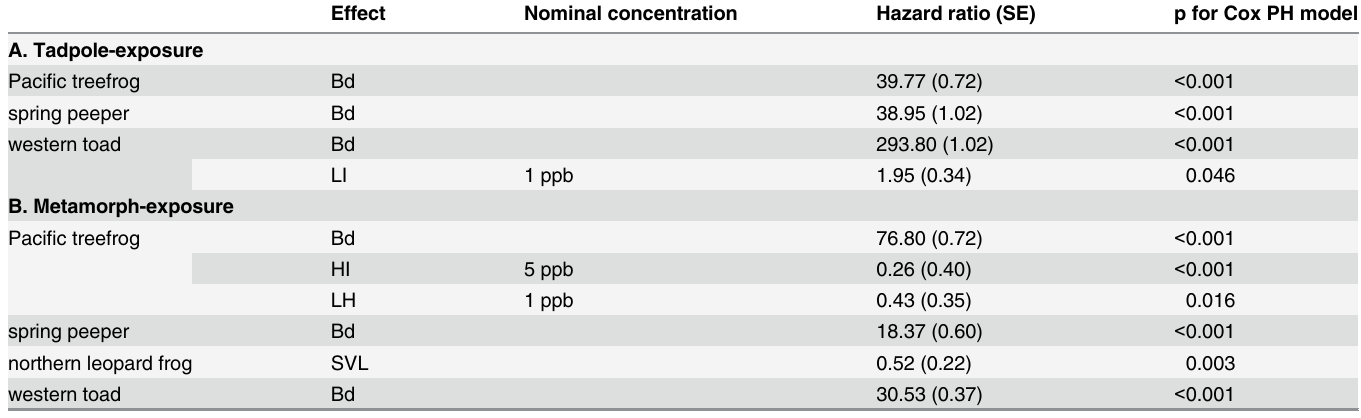
Table 1. For Amphibians Exposed To Pesticides As Tadpoles (A) And After Metamorphosis (B), Hazard Ratios And P-Values Indicating The Asso- ciation Between Probability Of Mortality And All Statistically Significant Risk